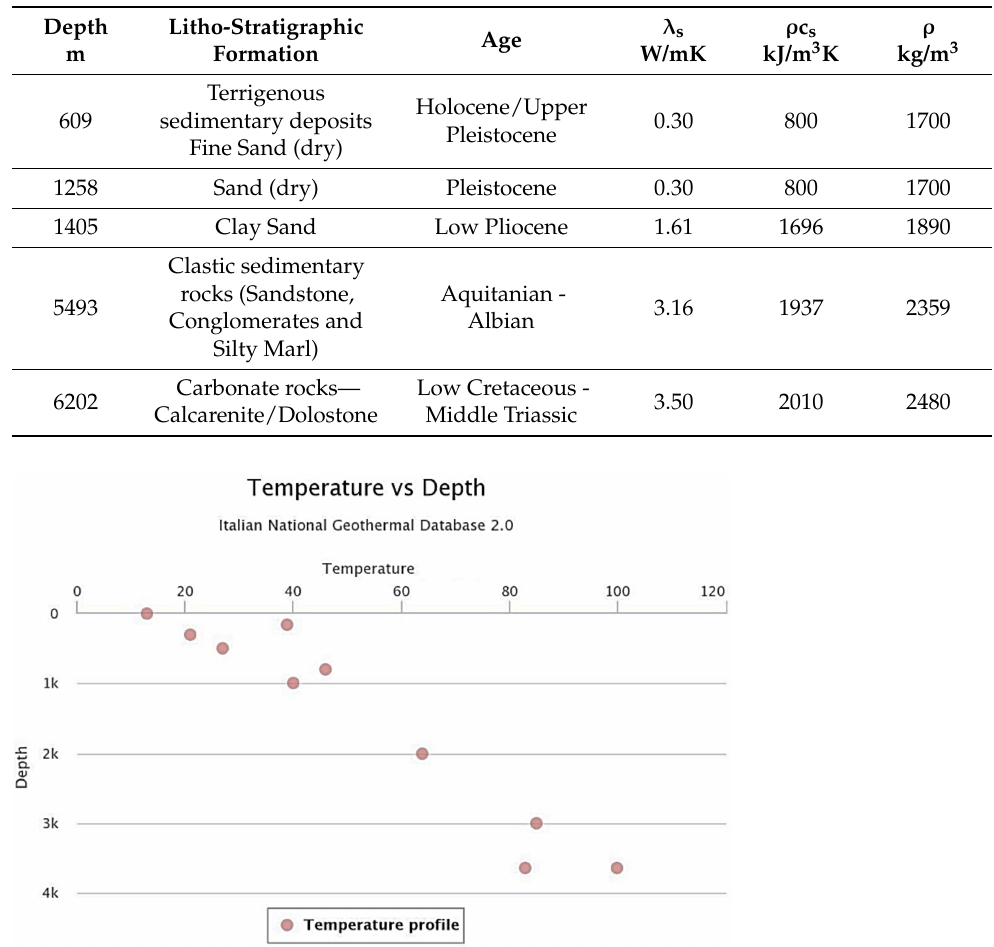
Figure 2. Temperature data visualisation for the Villafortuna 1 hydrocarbon well: Depth (m); Temperature ( ◦